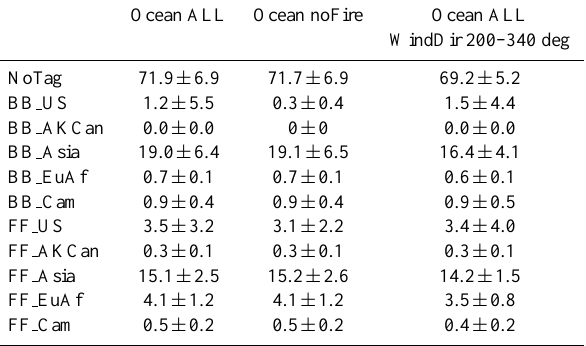
Table 4. Average CO Source Contributions for AVG RegionTime Ocean and the 0–1km altitude range. Units areppbV